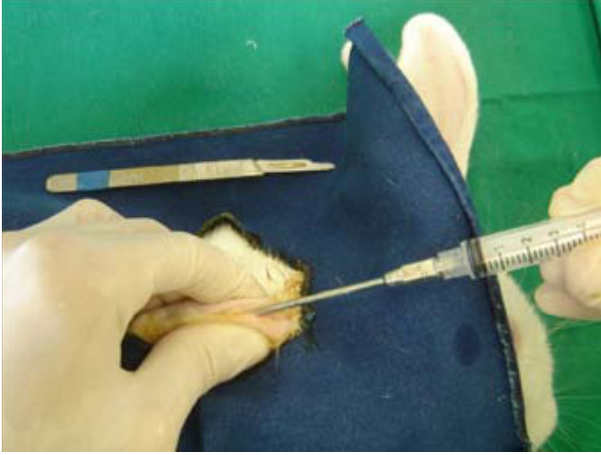
FIGURE 1 – Liposuction with syringe. Donor